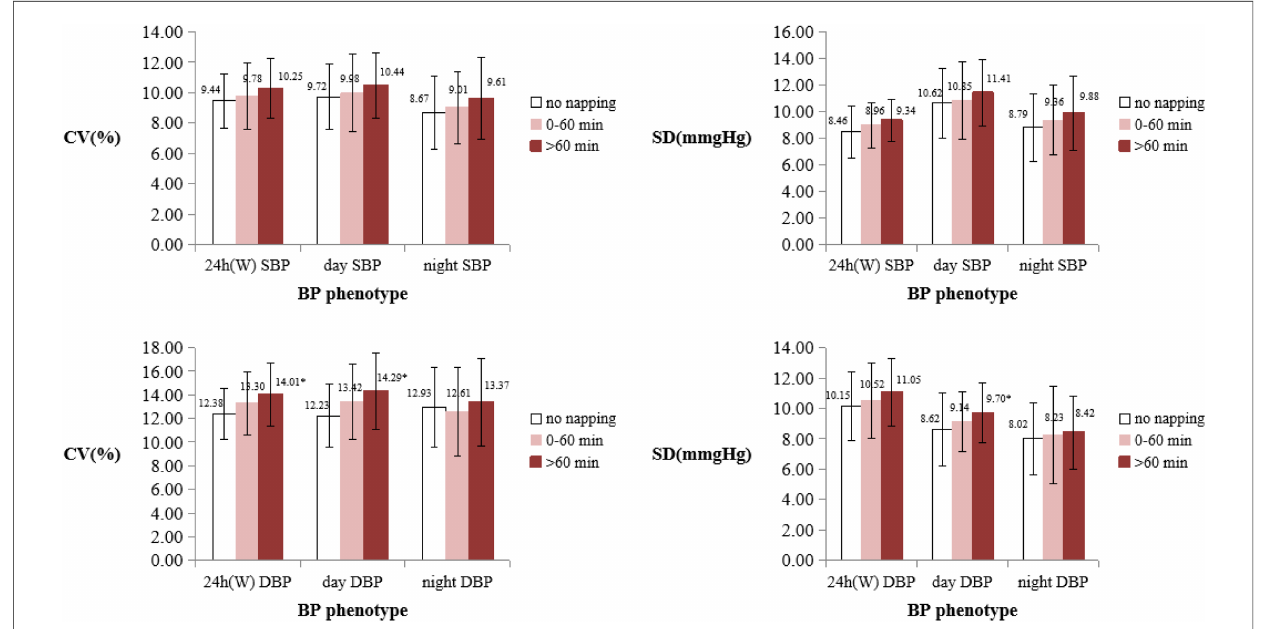
FIGURE 1 Comparison of BPV between different nap duration groups. BPV, blood pressure variability; DBP, diastolic blood pressure; SBP, systolic blood pressure; SD, standard deviation; CV, coef fi cient of variation; W, Means weighted. *Means that the BPV indicator is signi fi cantly different from the no napping group ( P